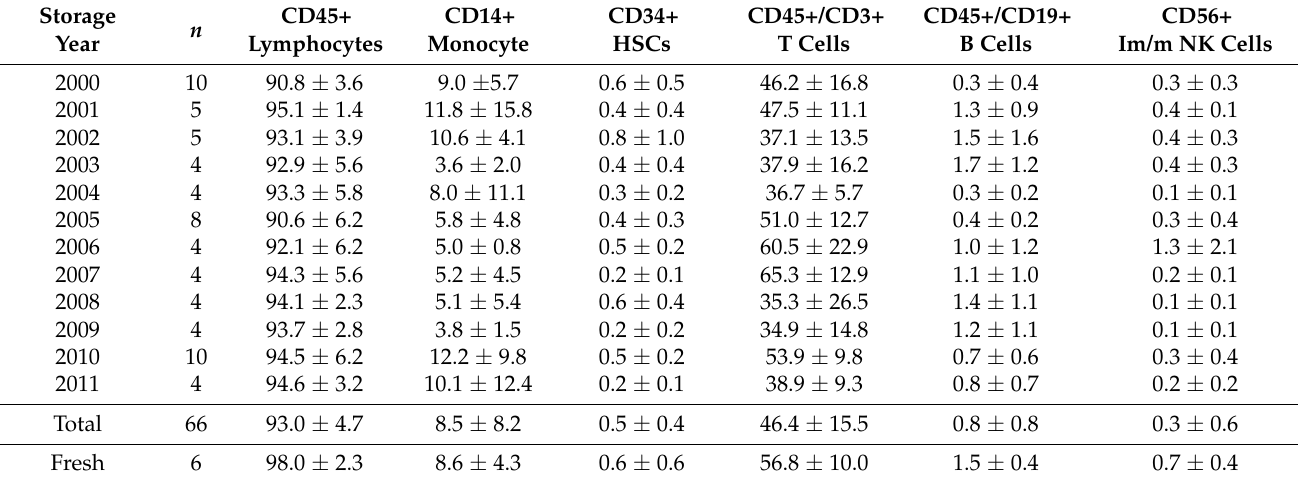
Table 2. Cell populations in MNCs isolated from 20-year cryopreserved and fresh umbilical cord blood (AVE ± SD, %).